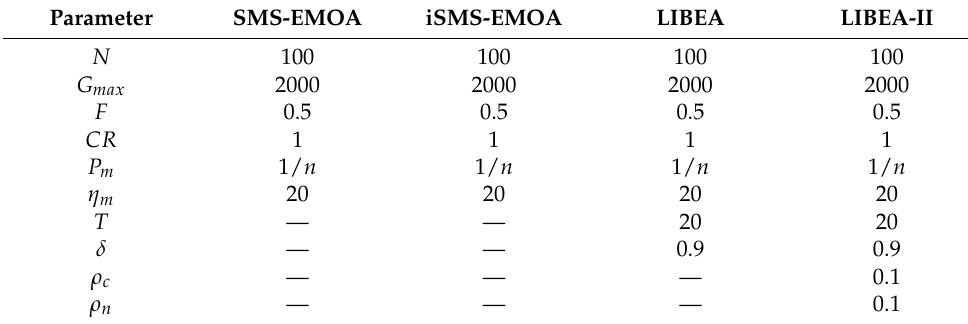
Table 2. Parameter settings for SMS-EMOA, iSMS-EMOA, LIBEA, and LIBEA-II. Parameter SMS-EMOA iSMS-EMOA LIBEA LIBEA-II N 100 100 100 100 G max 2000 2000 2000 2000 F 0.5 0.5 0.5 0.5 CR 1 1 1 P m 1/ n 1/ n 1/ n η m 20 20 20 20 T — — 20 20 δ — — 0.9 0.9 ρ c — — — 0.1 ρ n — — —